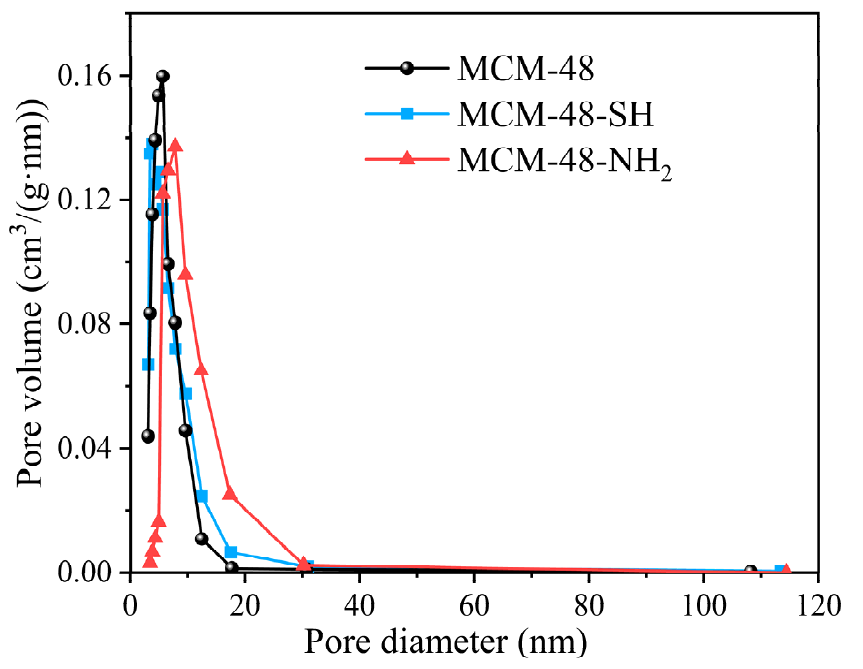
Figure 4. Pore size distribution diagram of MCM-48-SH, MCM-48, and MCM-48-NH 2 .